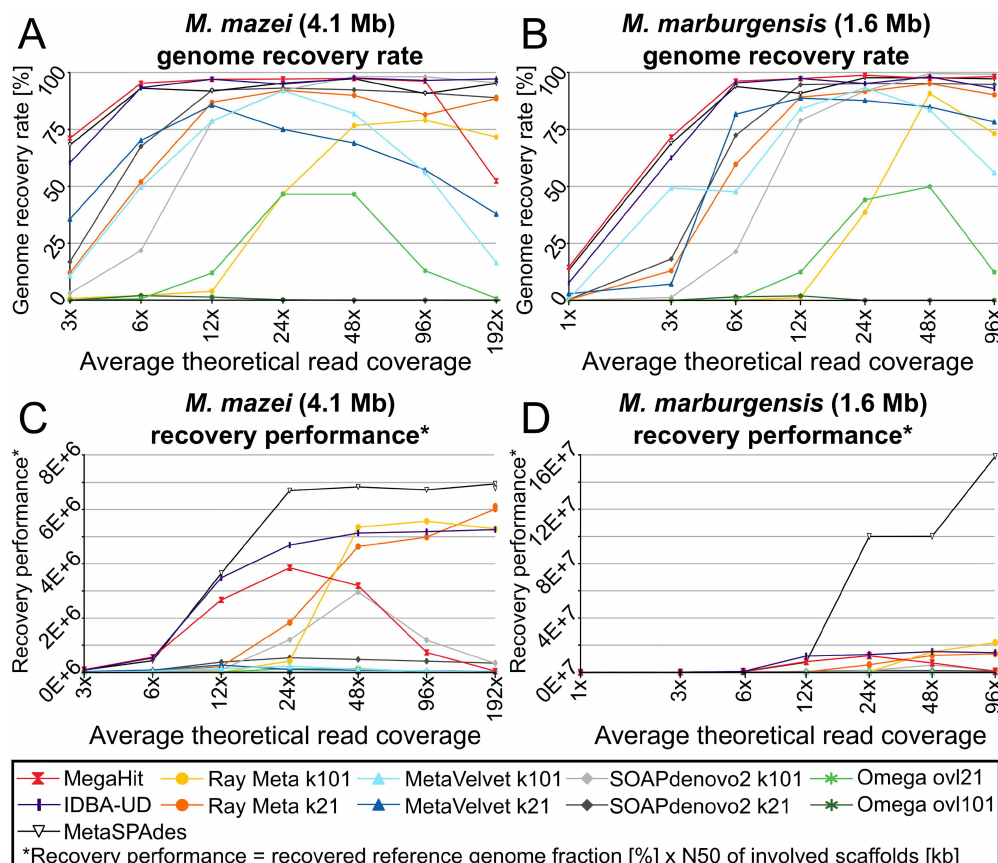
Fig 9. Recovery of known referencegenomes from artificial reads spiked into the kelp biofilm dataset. “Genome recovery rates” (A&B) are here definedas the fraction (in percent) of each reference genome,which could be reconstructed by each assembler.“Recovery performance” (C&D) is here definedanalogousto “assembly performance”in Fig 3, as the product of the genomerecovery rate and the N50 of the involvedscaffolds. A high recovery performance value, indicatinga good recovery performance, is therefore achievedby recoveringa large fraction of each reference genomein form of relatively few (and large) scaffolds.